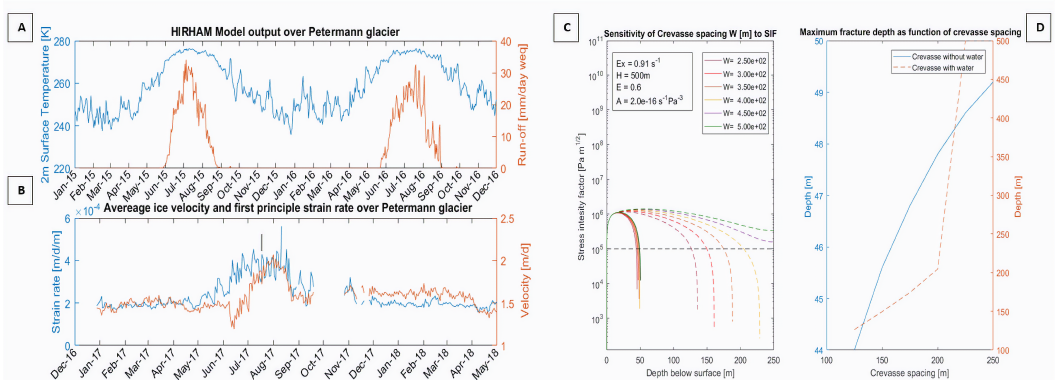
Figure 10. ( A ) HIRHAM modelled 2-m temperature (blue) and run-off (orange) averaged over the Petermann glacier . ( B ) Sentinel-1 ice velocity (orange) and first principle strain rate (blue) averaged over the Petermann glacier. ( C ) Stress intensity factor at different depths for varying crevasse spacing. Solid lines correspond to dry crevasses. Dashed lines to crevasses with a water level of 10 m below the surface. ( D ) Depth a crevasse reaches when the stress intensity factor equals the fracture toughness. Dry crevasses (blue), water filled crevasses